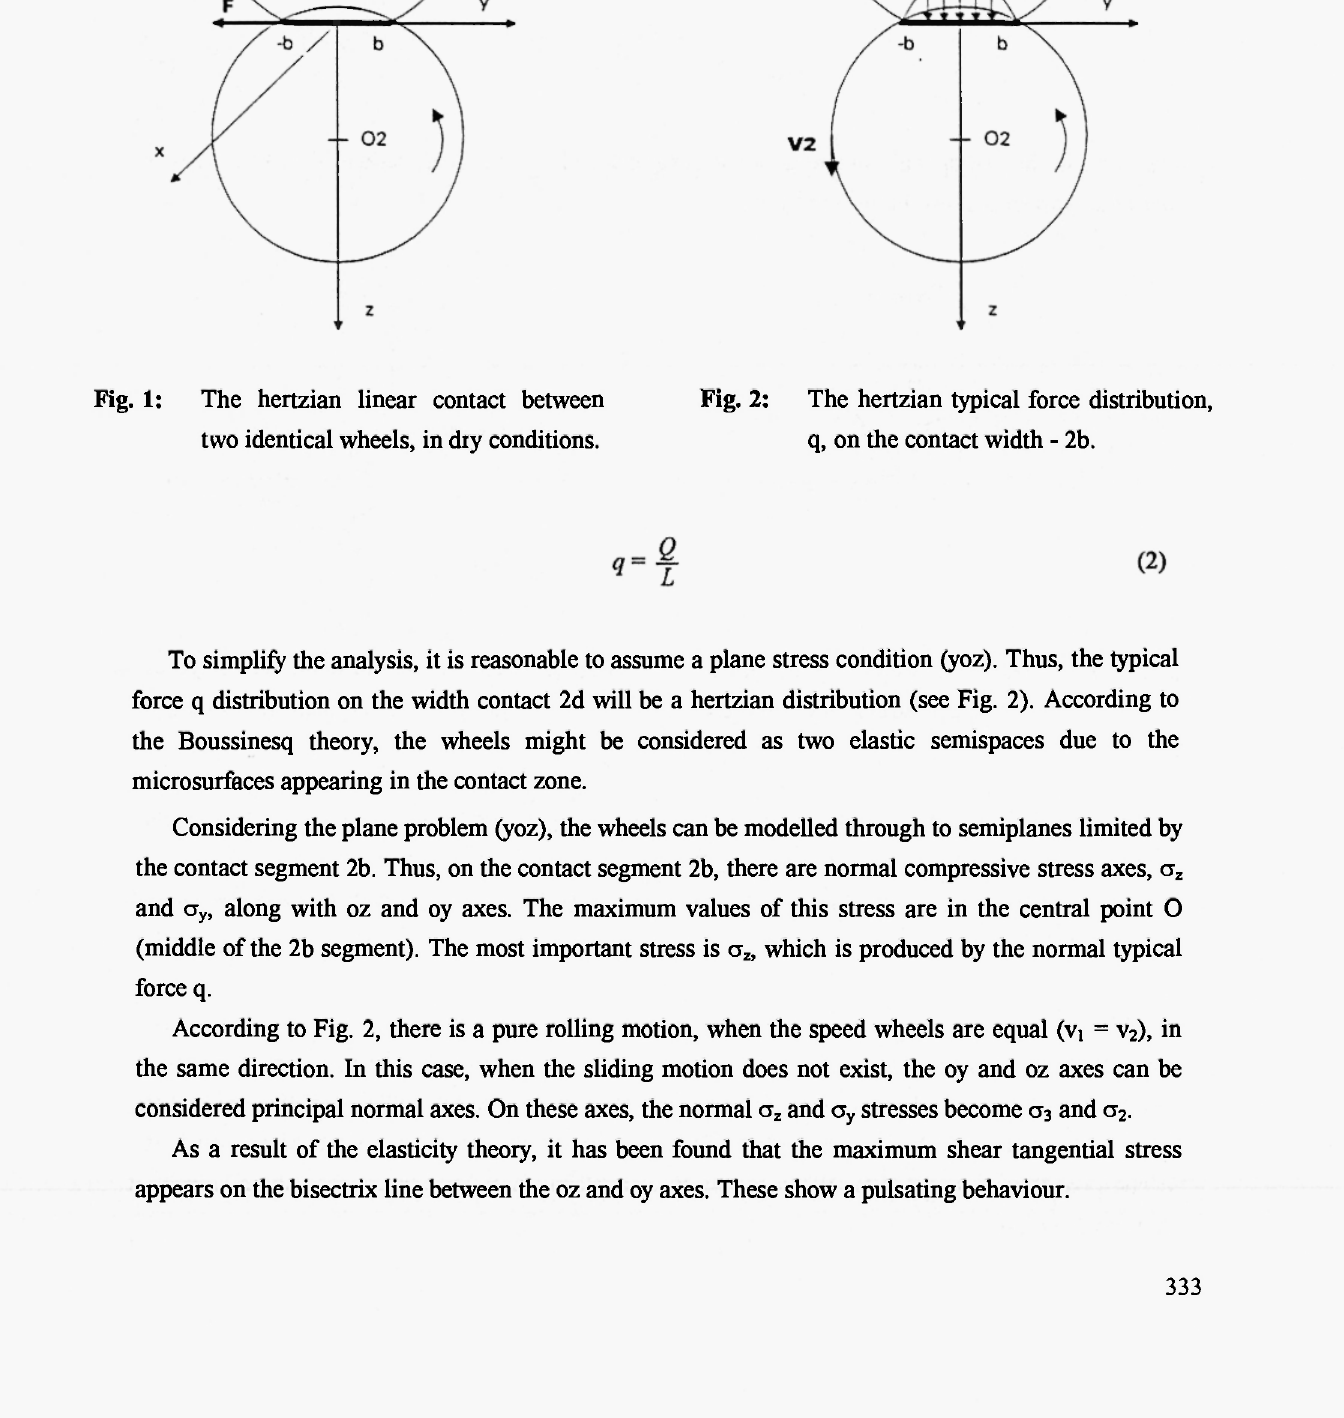
Fig. 1: The hertzian linear contact between Fig. 2: The hertzian typical force distribution, two identical wheels, in diy conditions. q, on the contact width -